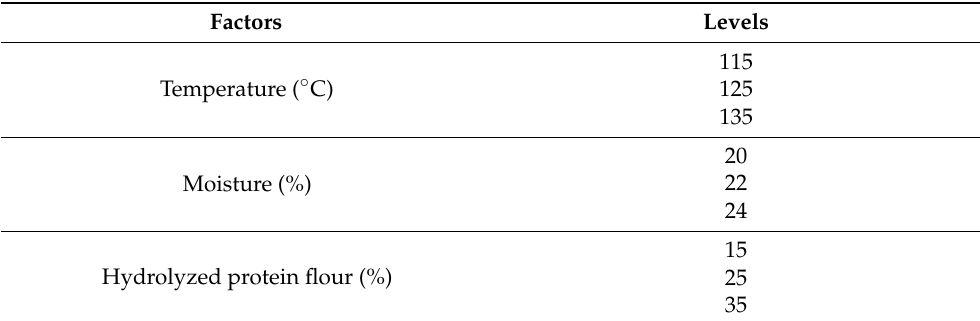
Table 3. Factorial design 3 3 applied to rheological evaluation.